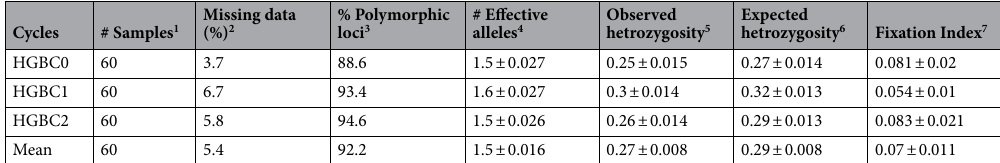
Table 5. Genetic variability based on SNP markers computed for HGB and its selection cycles. 1 # Number of samples correspond to number of plants from which leaf tissue was assayed. 2 Percent (%) of missing data is the percentage of markers that did not return data computed per cycle. 3 Percent of polymorphic loci is the percentage of polymorphic loci to the total number of loci (polymorphic and monomorphic) per cycle. 4 Number of effective alleles are the number of alleles that can be present in the population. 5 Observed heterozygosity is the number of markers within a population that are heterozygous calculated per cycle based. 6 Expected heterozygosity is the probability that at a single locus, any two alleles chosen at random from the population are different to each other. 7 Fixation index is the measure of reduction in heterozygosity.